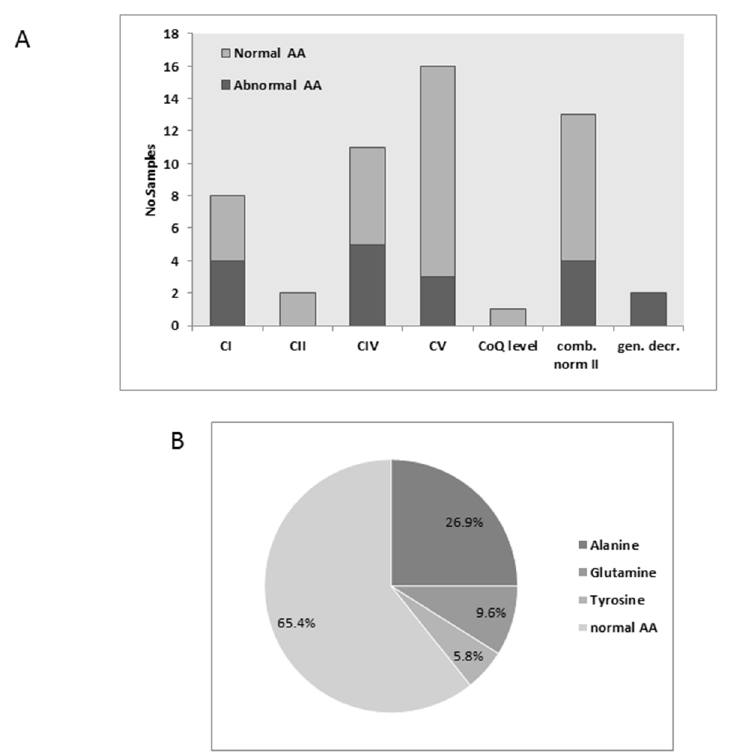
Figure 2. Plasma amino acids: ( A ) The relative proportion abnormal to abnormal plasma amino acid (AA) tests results according to groups. ( B ) The relative proportion of the most frequent abnormalities.